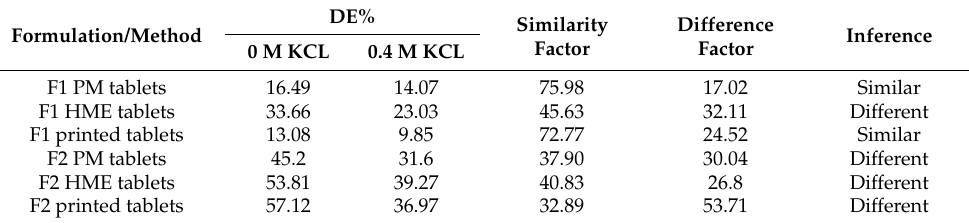
Table 4. DE% values obtained from dissolution testing performed with a dipping rate of 10 dpm at two different ionic strengths, the baseline ionic strength (0 M KCl added) and 0.2 M added KCl, along with similarity ( f 2 ) and difference ( f 1 ) factors for these two profiles.